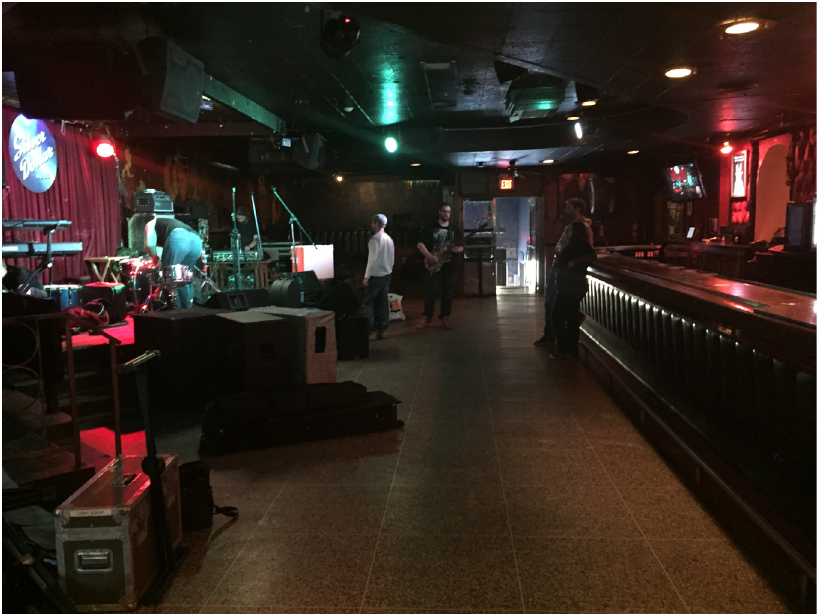
Figure 2. Interior of the Silver Dollar Room, viewed from the rear of the venue. The bar is on the right side and the stage is on the left. The center part is generally where the audience stands during live music performances. In this photo, a band is setting up their performance space for later that